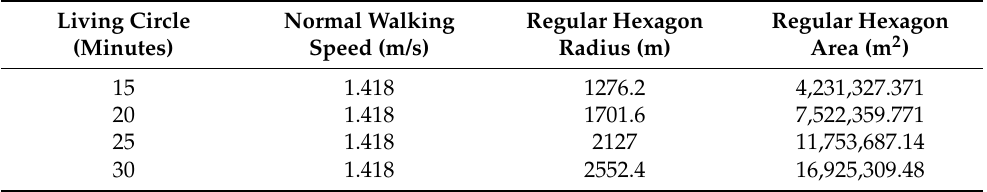
Table 2. Regular hexagons in four living circle